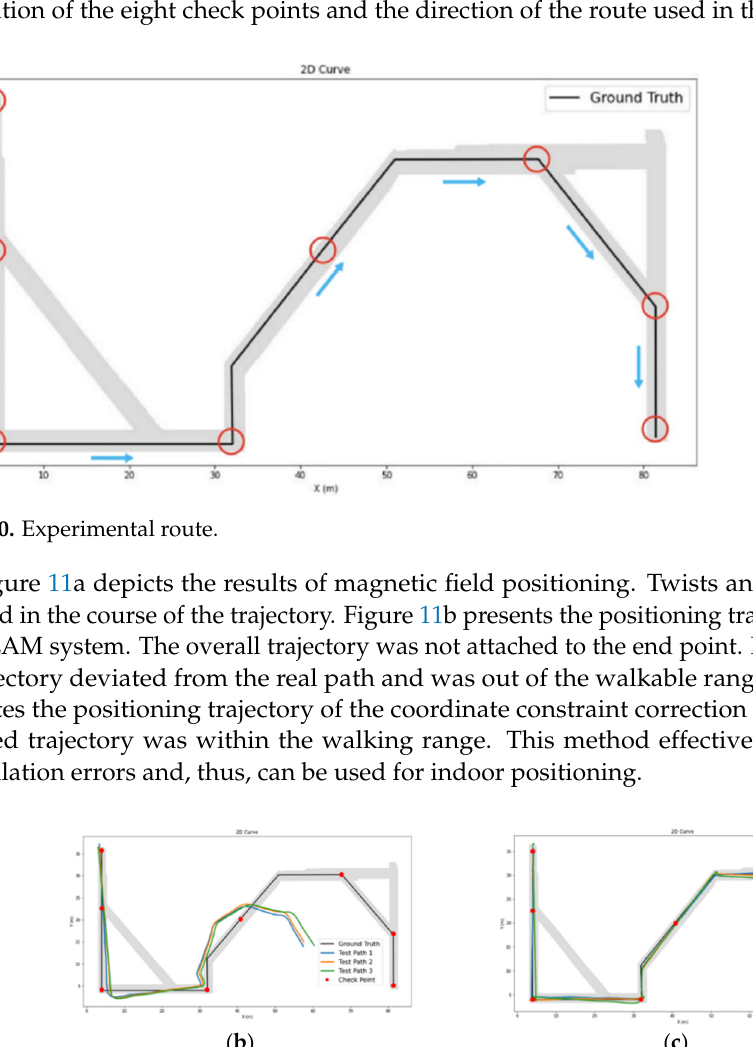
Figure 9. Schematic of conversion parameters.